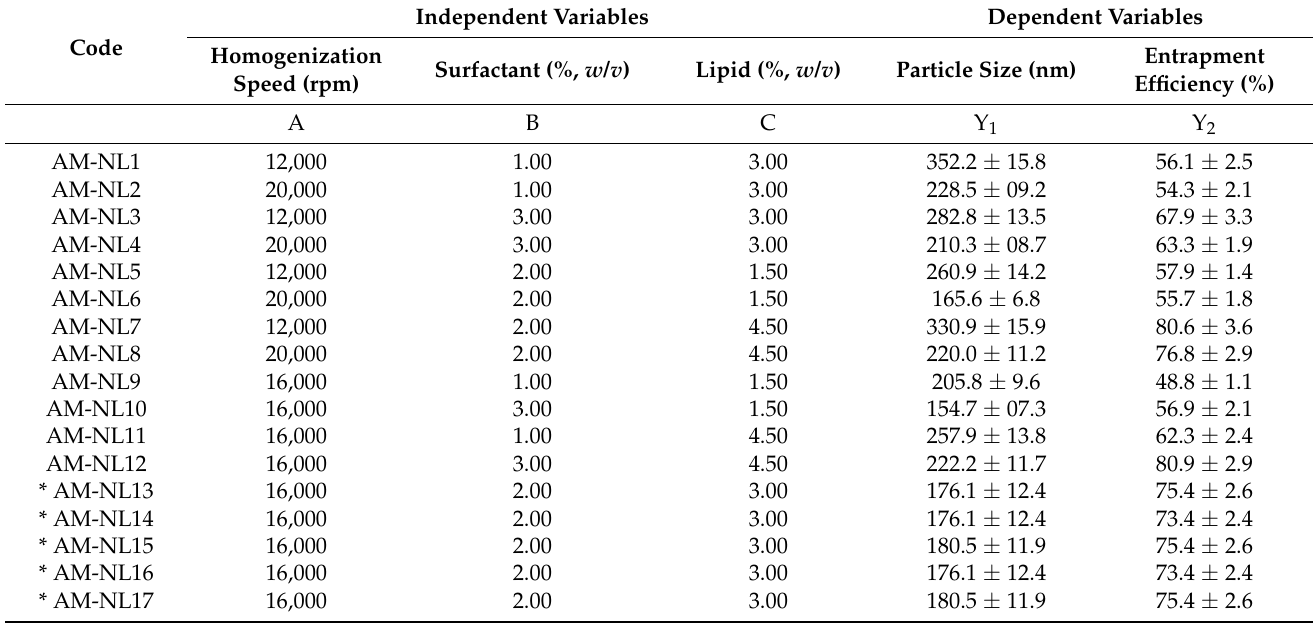
Table 1. Composition of Azithromycin nano lipid carrier with experimental